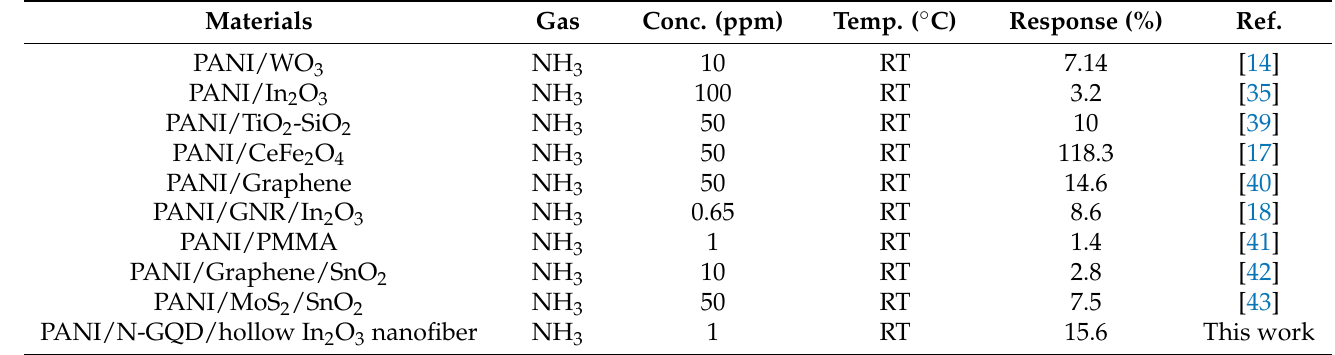
Table 2. Comparison of NH 3 -sensing performance of the PANI/N-GQD/hollow In 2 O 3 nanofiber sensor developed here with other sensors reported recently.